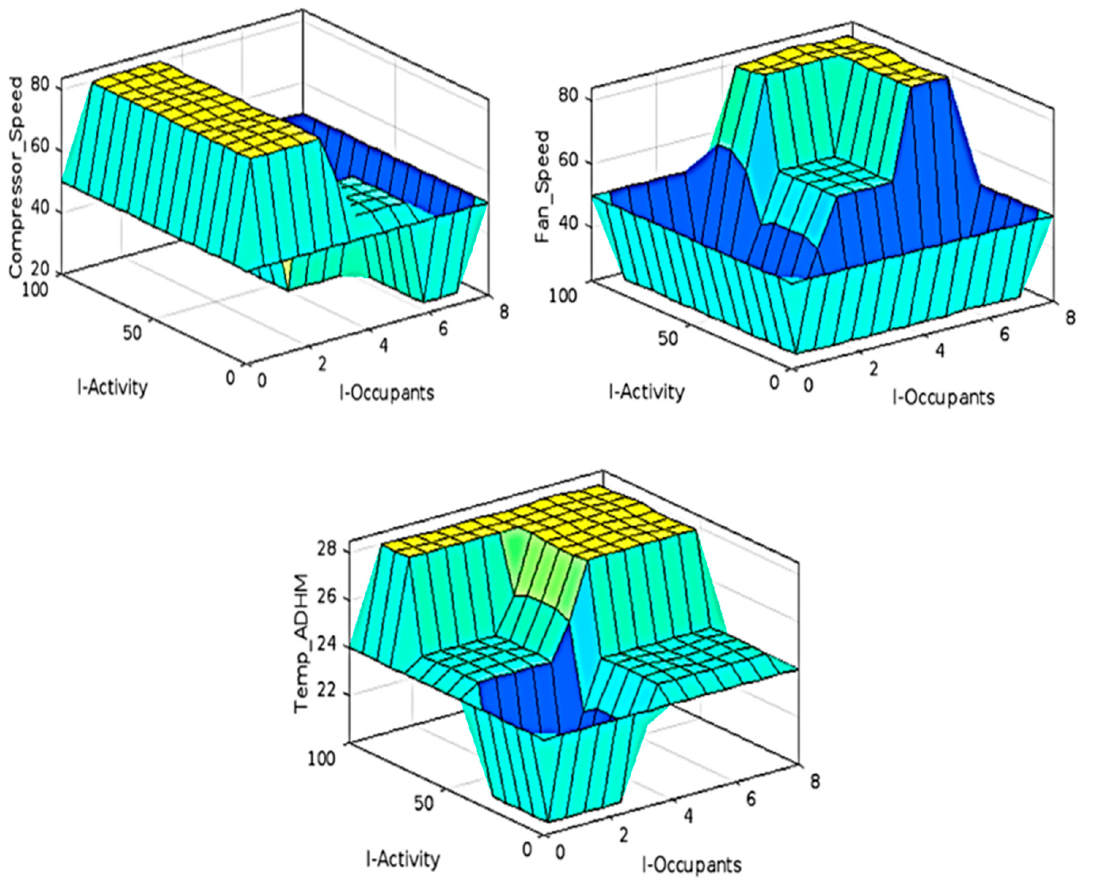
Figure 4. Surface viewer of compressor speed, fan speed, and temperature in relation to ID-occupants and ID-activity (indeterminacy).